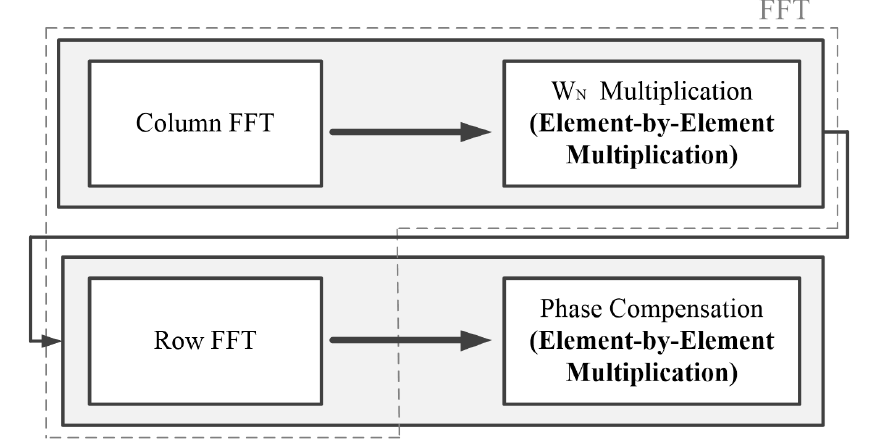
Figure 5. Procedure of FFT and phase compensation.